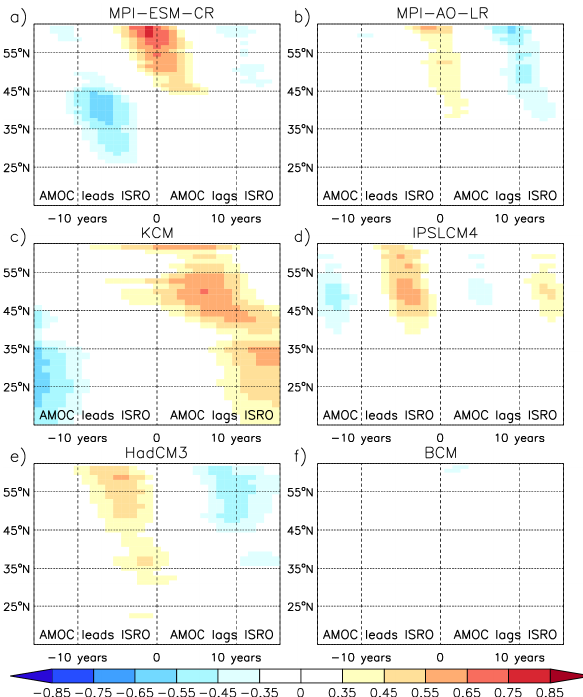
Fig. 5. Same as Fig. 3, but for the correlation between overflow transport across the Iceland–Scotland Ridge (ISRO) and Atlantic meridional overturning